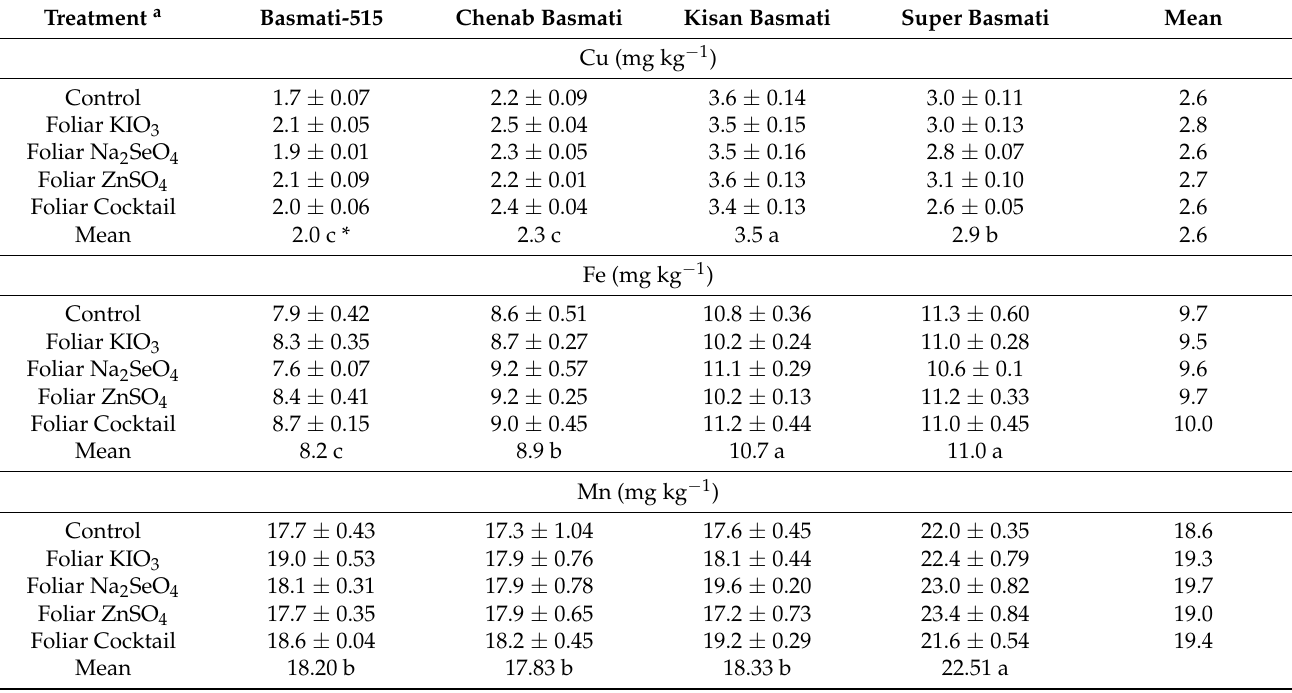
Table 4. Effect of foliar treatments on Cu, Fe, and Mn concentration in brown rice grains of different Basmati